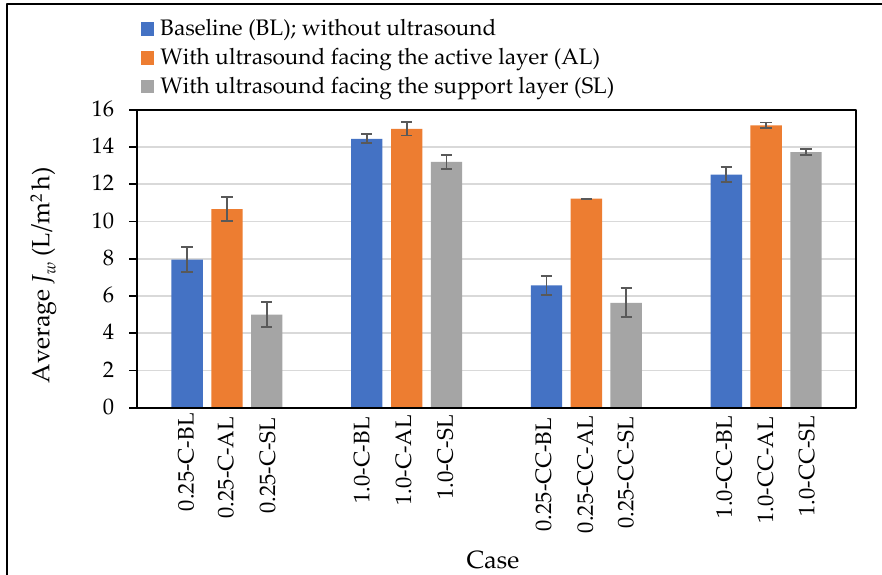
Figure 3. Average J w for the cases with and without the use of ultrasound for NaCl draw solution. The error bar represents the lower and upper average J w associated with the two runs of the tested case.